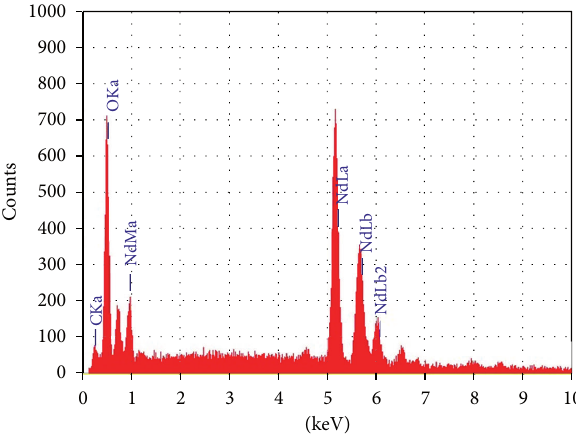
F 10: SEM-EDX image of Nd T 2: Electronic spectral data lanthanide complexes of